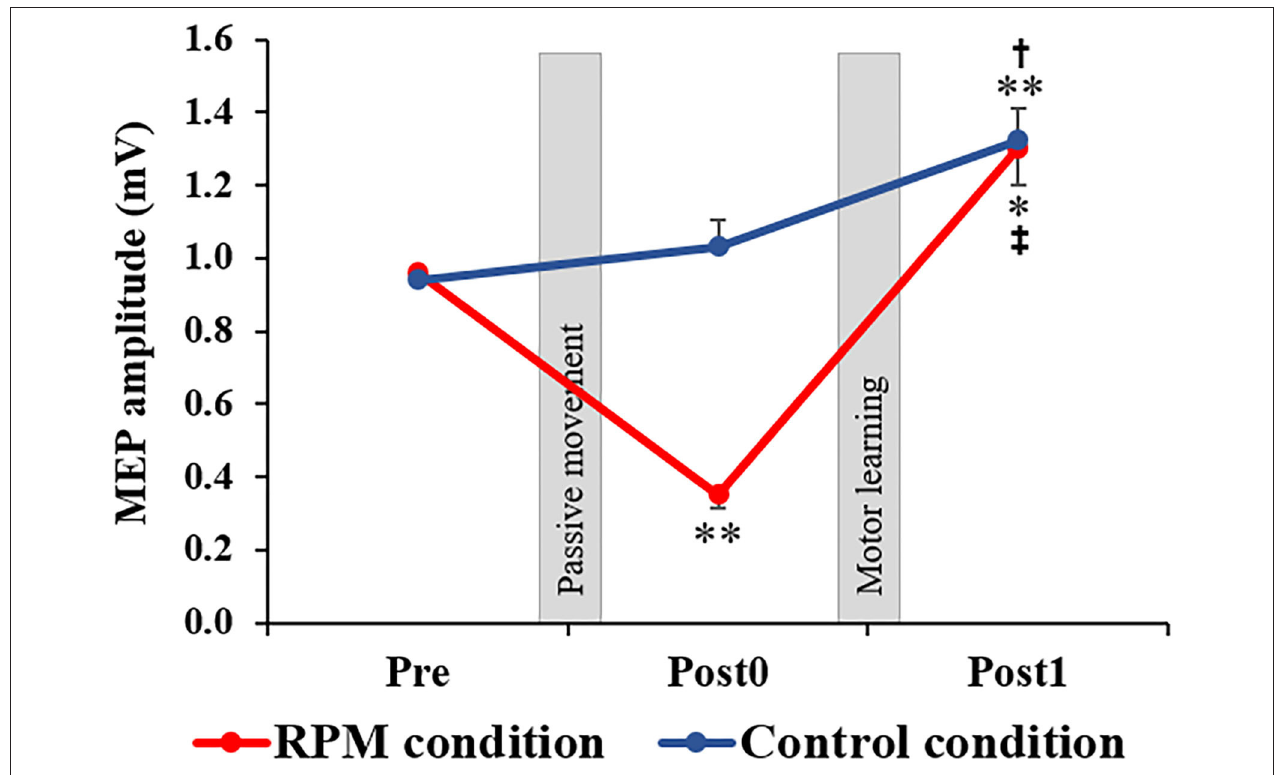
FIGURE 4 | Changes in MEP amplitude in each condition. The red line indicates the average of the MEP amplitudes in the RPM condition. The blue line shows the average of the MEP amplitudes in the Control condition. The error bars indicate the standard error (SE). After each intervention, the MEP amplitude was significantly reduced in the RPM condition, whereas no change was observed in the Control condition. After the motor learning task, the MEP amplitude of the RPM condition increased to the same level as that of the Control condition. * P < 0.05 (vs. Pre); ** P < 0.01 (vs. Pre). † P < 0.05 (vs. Post0); ‡ P < 0.01 (vs.